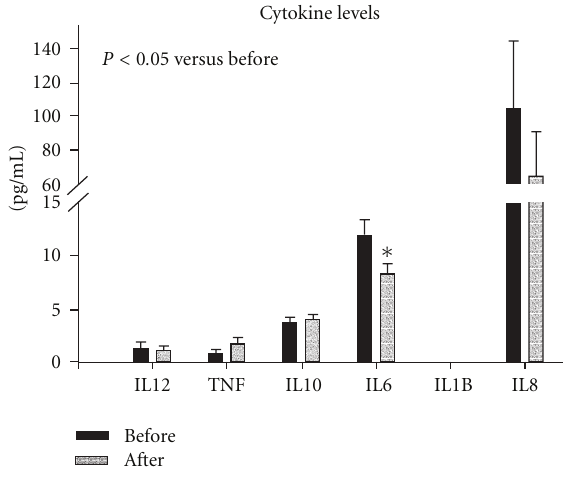
Figure 3: Multiple inflammatory cytokines were measured by flow cytometry using a cytometric bead array. Graph summarizes results. Black bar is before intensive treatment and grey bar after intensive treatment. No IL-1 β was detected in any samples. ∗ P < 0 . 05 versus before